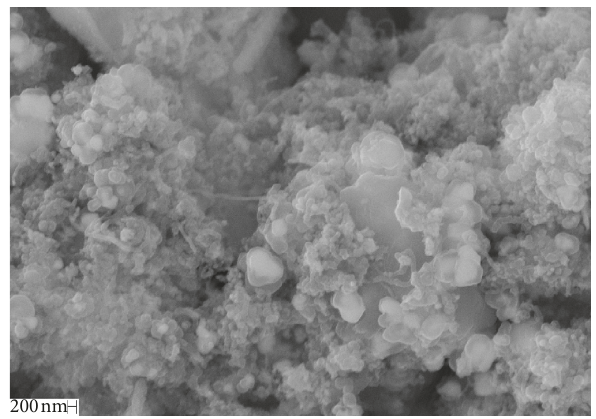
Figure 9: SEM image of sample 20Ni20YZ ( × 50000) after POM reaction.